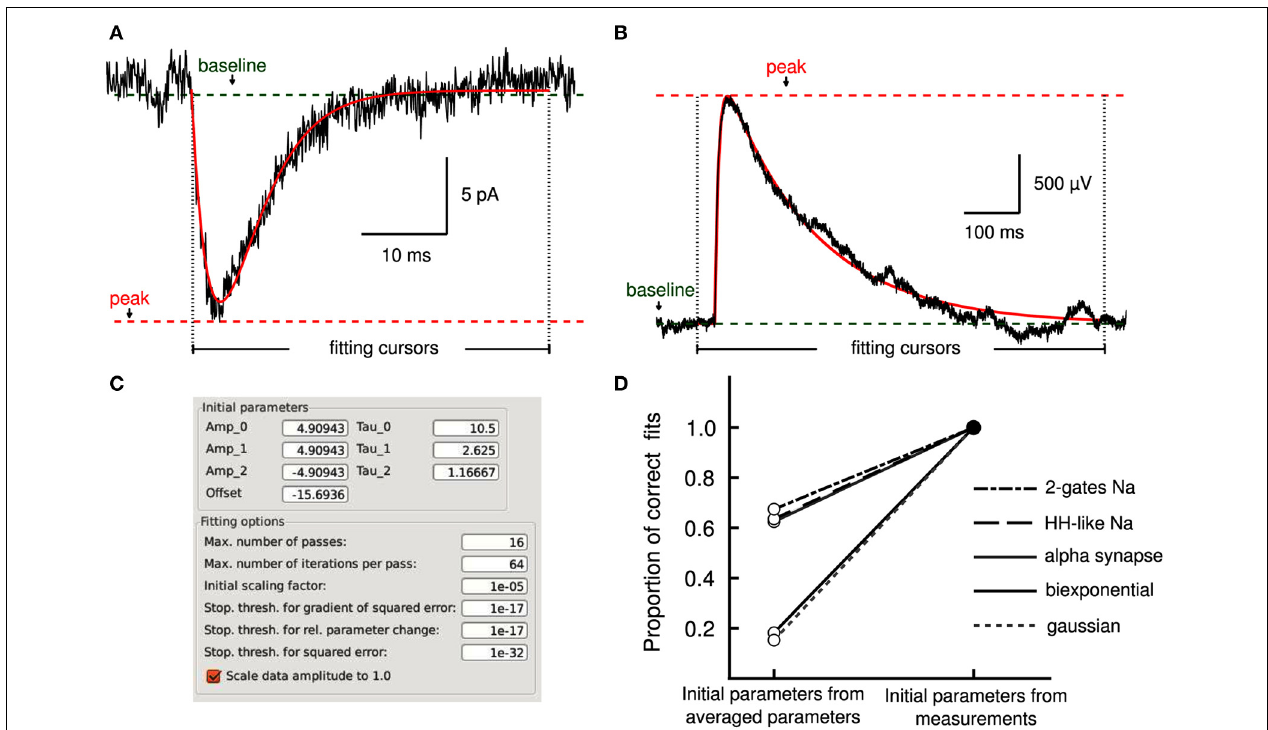
algorithm. (C) User interface allowing detailed manipulation of both initial parameters to the fitting model, and fitting options of the fitting algorithm. (D) Without the aid of the measurements to obtain adequate initial estimates, only a proportion of fits converges on the correct values (an SSE between trace and fit > 0.001 is considered as a failure). If initial estimates are derived from the measurements (baseline, peak, rise time, and half-width), the fits converge correctly in all cases.